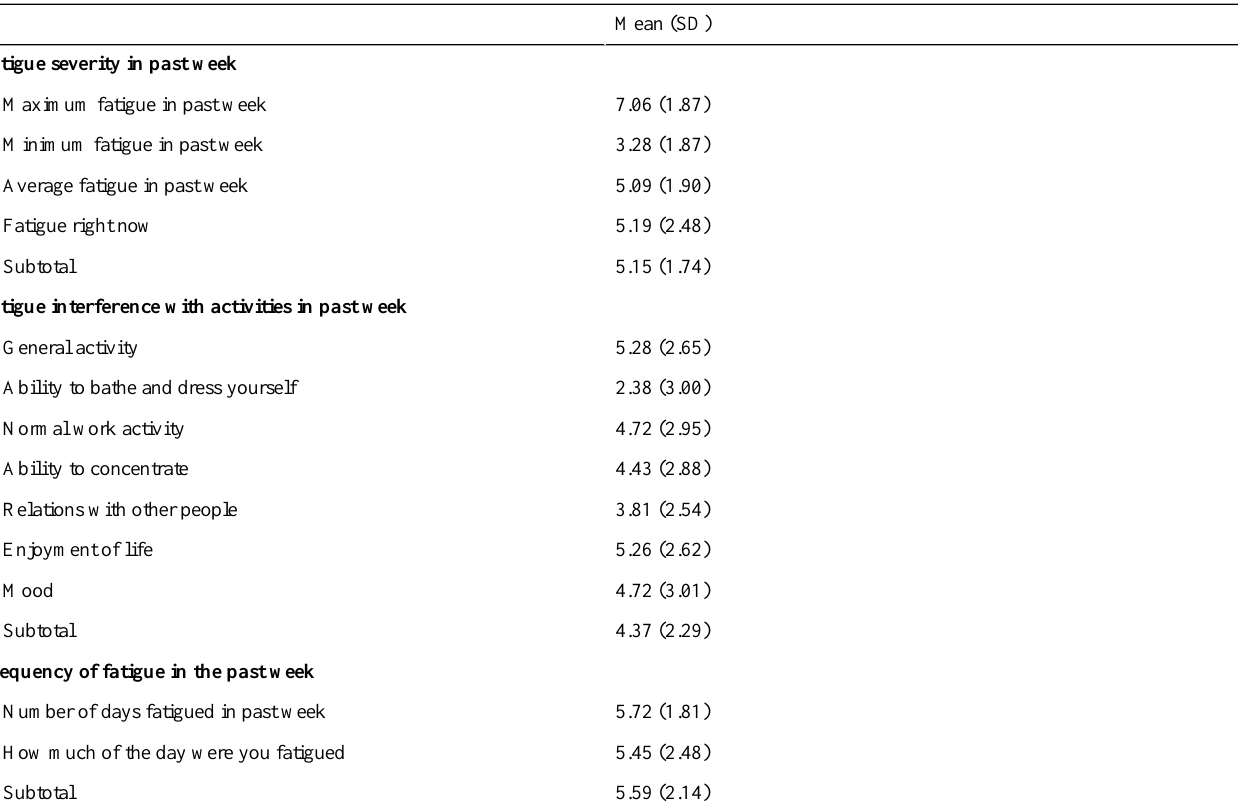
Table 3. Descriptive statistics of the Fatigue Symptom Inventory